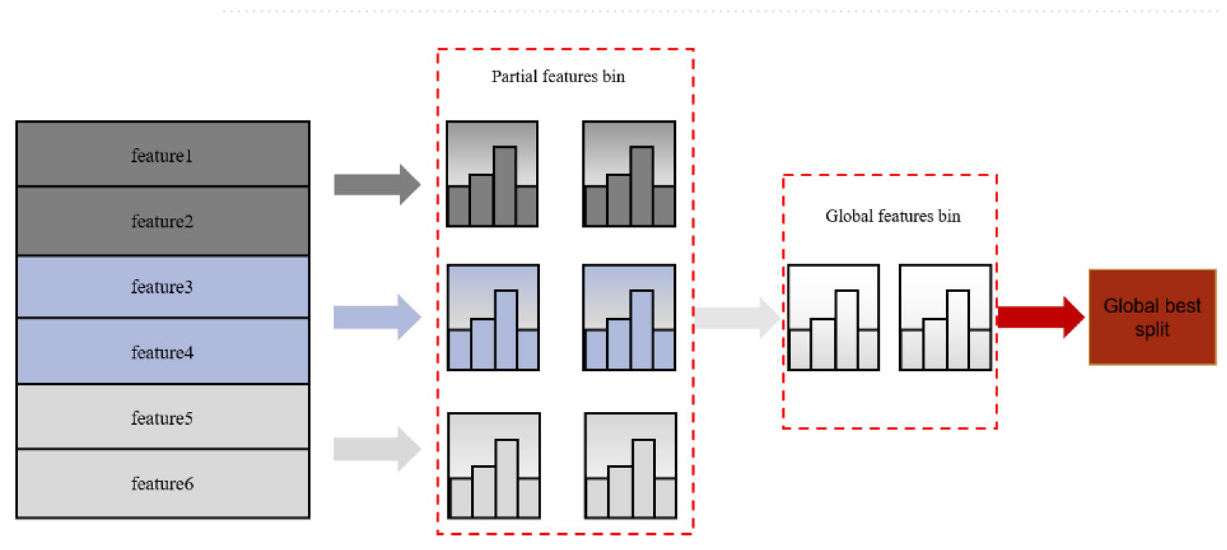
Table 1. Development history of boosting algorithm.